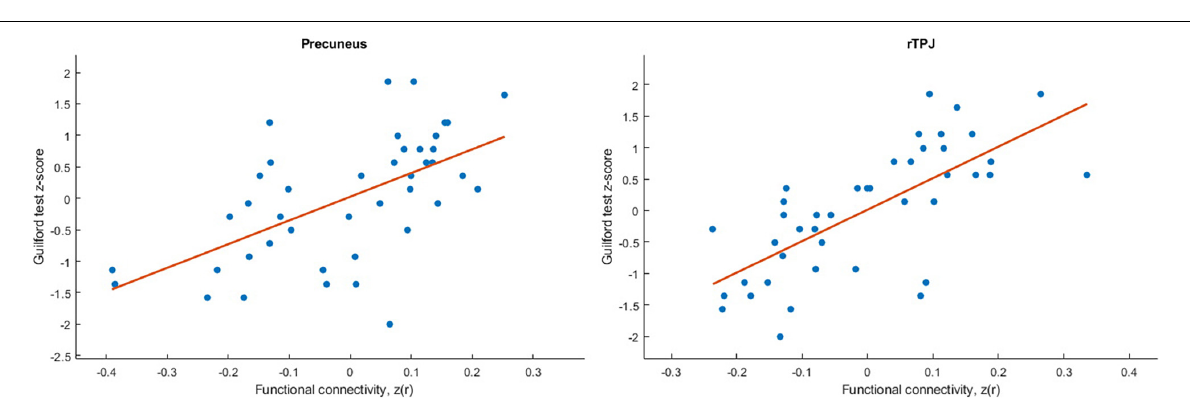
FIGURE 3 | Statistical parametric maps of seed-based analysis and multiple regression with the z-transformed sum of raw scores as a covariate of interest, where the seed was located in the right caudate head, at p < 0.05, FWE cluster-level corrected.